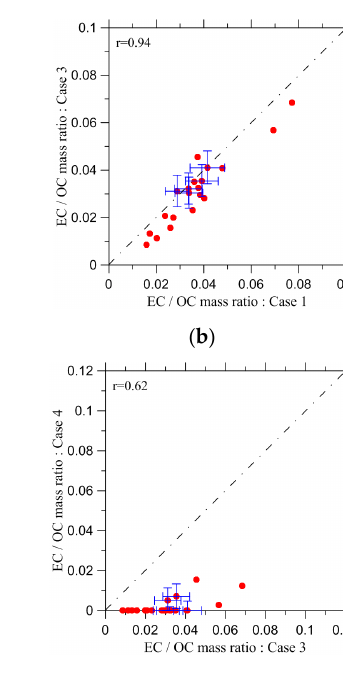
Figure 4. The AERONET SSA observations ( ω 0 ) at ( a ) 675 nm and ( b ) 440 nm plotted as a function of the corresponding observations at 869 nm. Also shown are linear regressions (and their equations) fitted with the orthogonal distance regression (ODR) method and the 90% confidence intervals (given in parentheses) of the fits. The regressions were fit by considering the observations from the TOMSK-22 and Yakutsk sites all together.